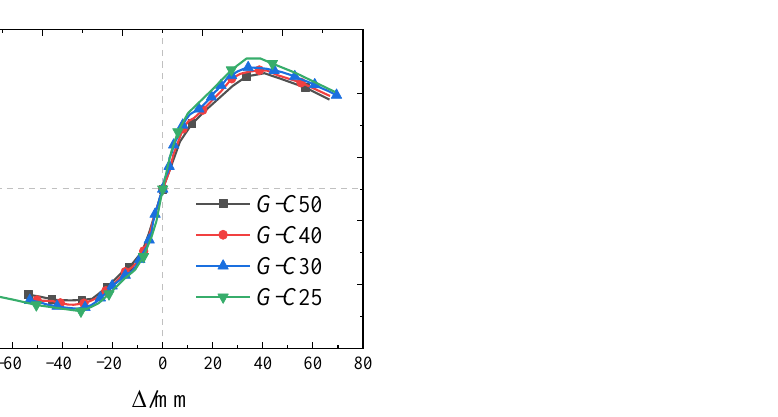
Figure 26. Load–displacement skeleton curves of models with different RCFSTK concrete Figure 26. Load – displacement skeleton curves of models with different RCFSTK concrete grades.